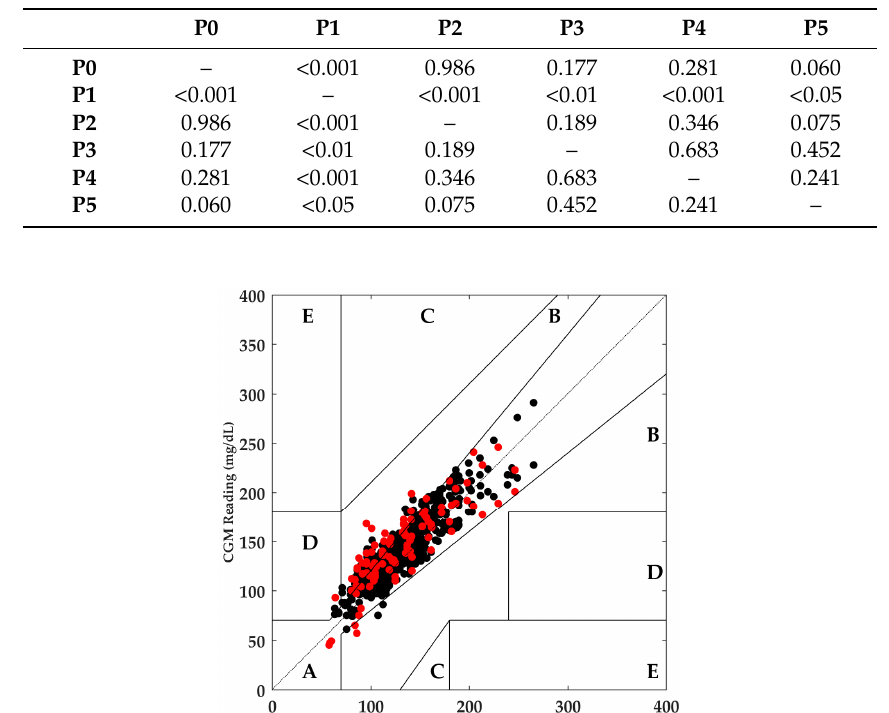
Figure 2. Clarke error grid analysis of CGM and PG values for aerobic exercise. Zone A: 81.6%, Zone B: 18.1%, Zone C: 0.0%, Zone D: 0.3%, Zone E: 0.0%. Red points illustrate the readings during P1. CGM, continuous glucose monitor; PG, plasma glucose.